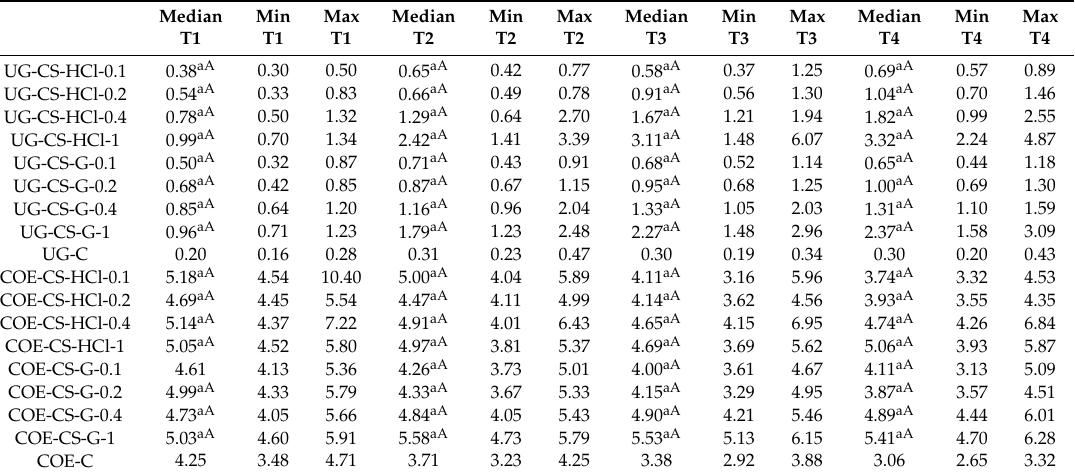
Table 4. Descriptive data for surface roughness (Ra) in µ